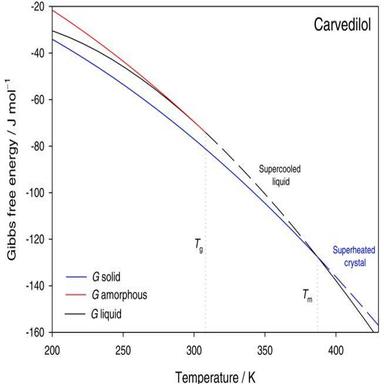
Gibbs energy (free enthalpy, G) as a function of temperature for carvedilol.